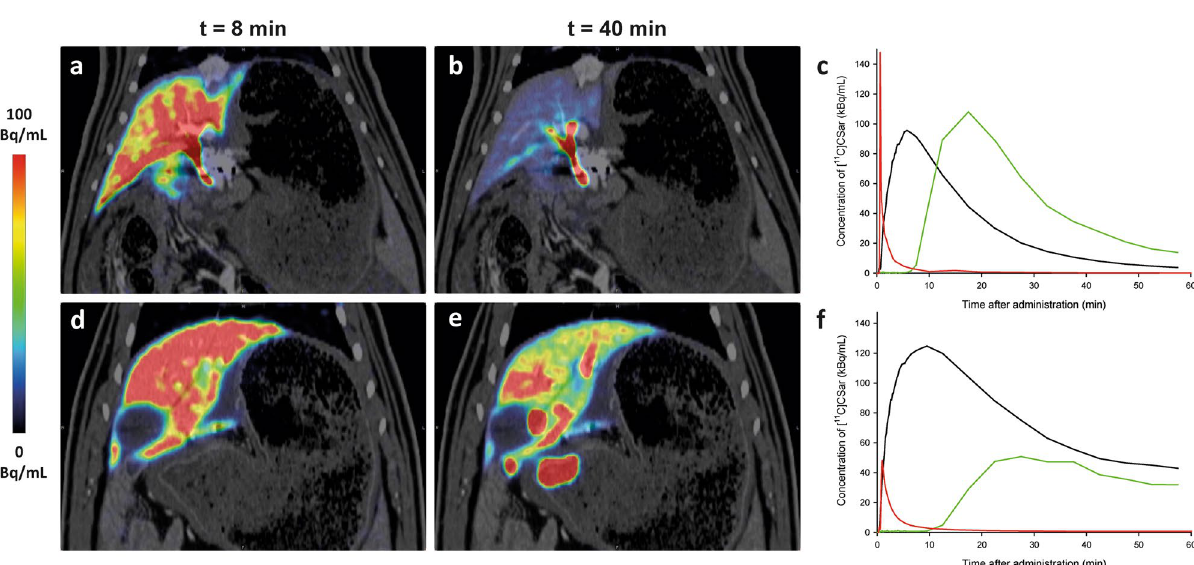
Figure 2. PET/CT images and time activity curves from dynamic [ 11 C]CSar scans in a control pig (Pig C3; a – c ) and an irradiated pig with lobular inflammation and impaired hepatobiliary function (Pig R4; d – f ). The PET/ CT images are coronal and show average concentration recorded 7.5–8.5 min ( a , d ) and 37.5–42.5 min ( b , e ) following bolus injection of 78 MBq [ 11 C]CSar. Panels ( c , f ) display the time course of [ 11 C]CSar concentration in arterial blood (red), liver tissue (black), and the common hepatic duct (CHD), divided by 50 (green). In both pigs, [ 11 C]CSar is rapidly cleared from blood and accumulated in the liver tissue. In the control pig, [ 11 C]CSar is almost completely cleared from the liver and excreted into the CHD at 37.5–42.5 min, while high concentrations of [ 11 C]CSar still remain in the liver of the irradiated pig and is excreted at a reduced